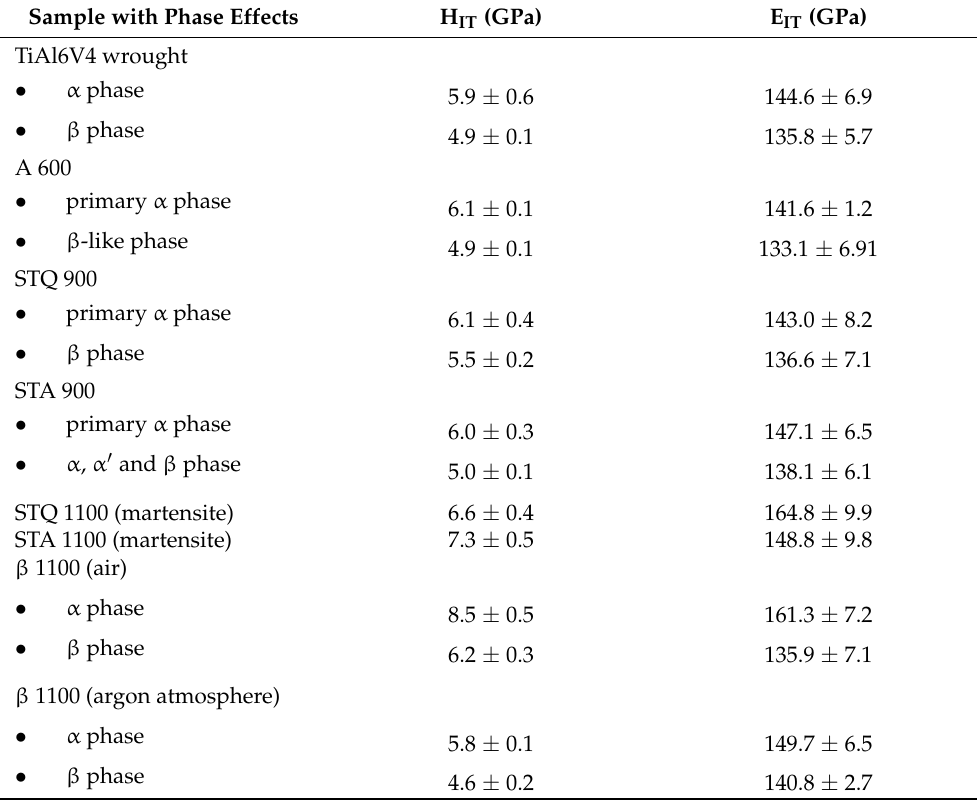
Table 3. Hardness, H IT , and indentation modulus, E IT , derived from nanoindentations show a distinct effect for the phases present in the heat-treated TiAl6V4 alloys (data as mean ± SD, n = 10). All samples were heat-treated in air and only one reference sample, β 1100, was heat-treated in argon atmosphere. Sample with Phase